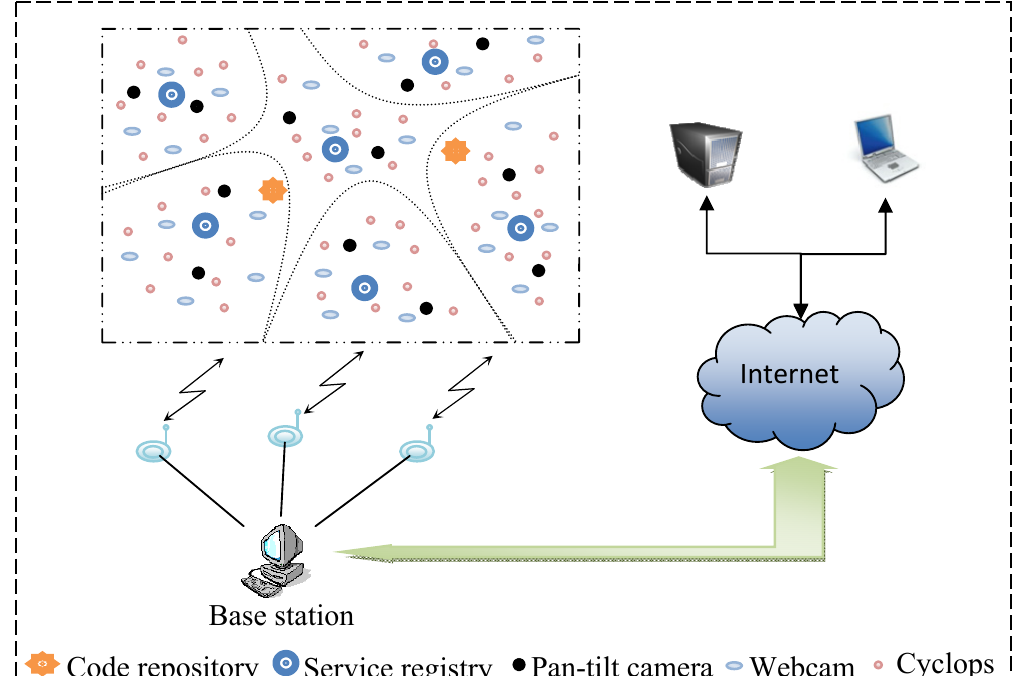
Figure 1. Overall view of a GWMSN designed based on